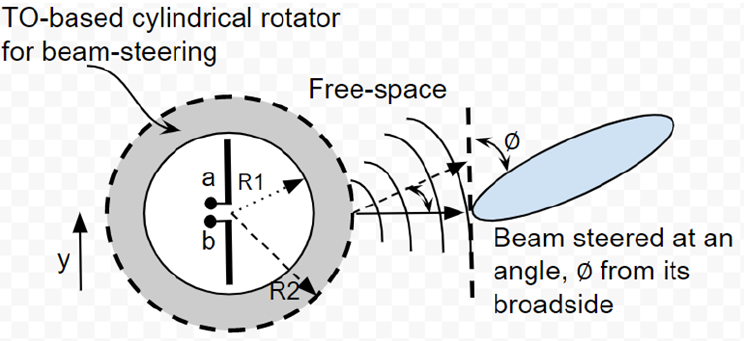
Figure 3. Metamaterial based cylindrical beam-steerer using TO enclosing a single dipole element